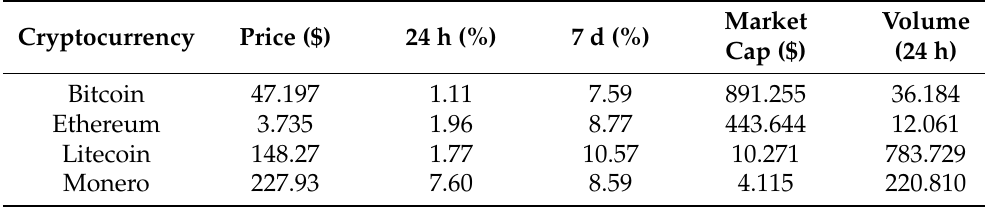
Table 2. Dataset information for the four cryptocurrency